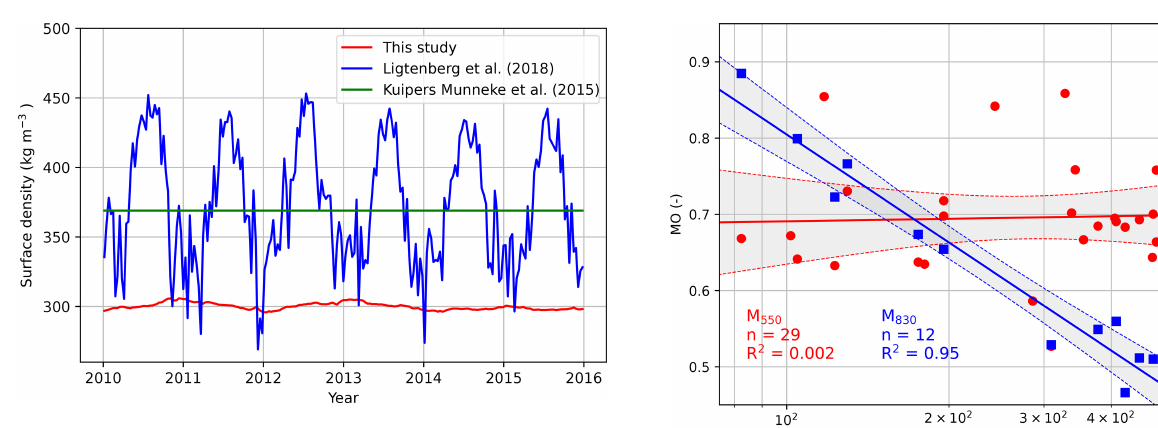
Figure 1. Daily averages of Das 2 (southeast Greenland; see Fig. 4) surface density (2010–2016) using three different parametrizations.